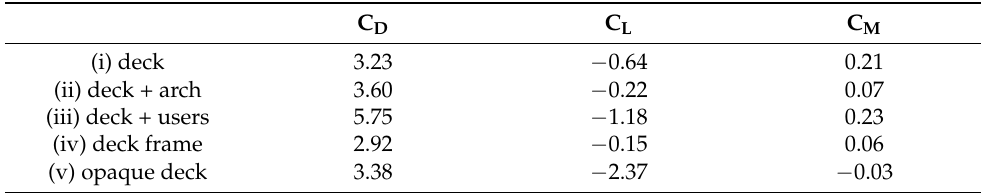
Table 1. Maximum aerodynamic coefficients for small angles of